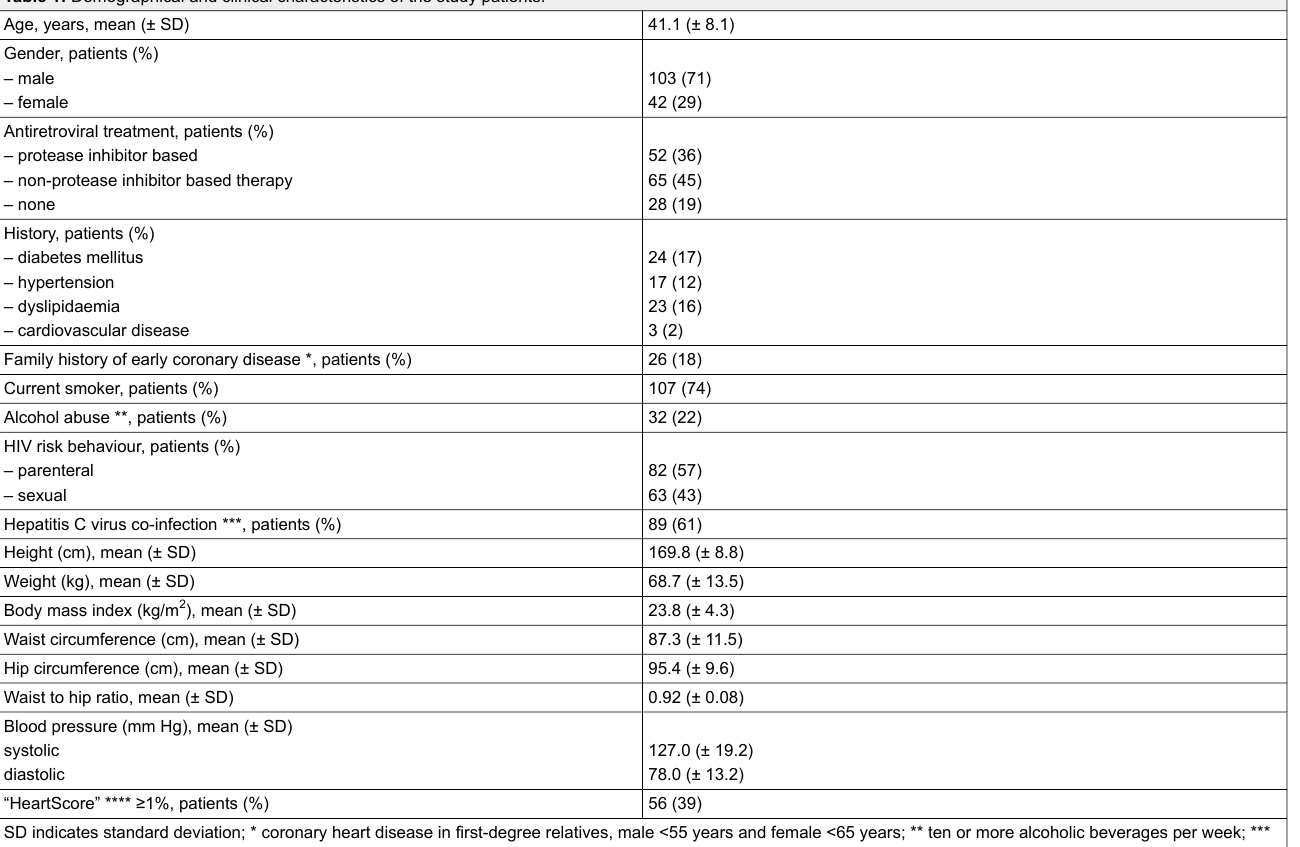
Table 1: Demographical and clinical characteristics of the study patients. Age, years, mean (±